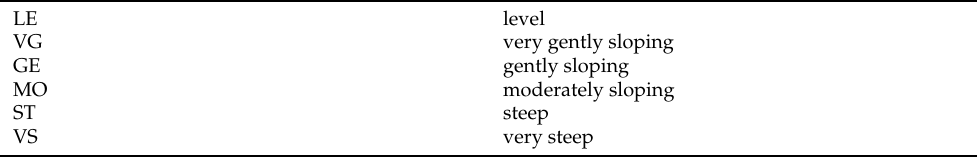
Table 2. Slope codes used by [54].